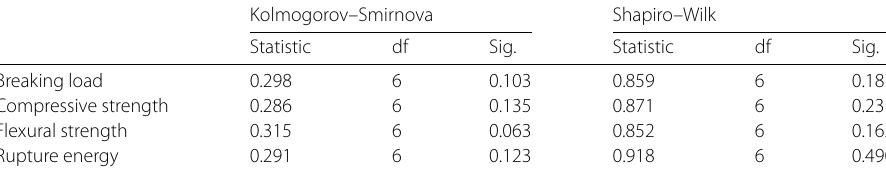
Table 4 The table of the normality test of the mechanical data Kolmogorov–Smirnova Shapiro–Wilk Statistic df Sig. Statistic df Sig. Breaking load